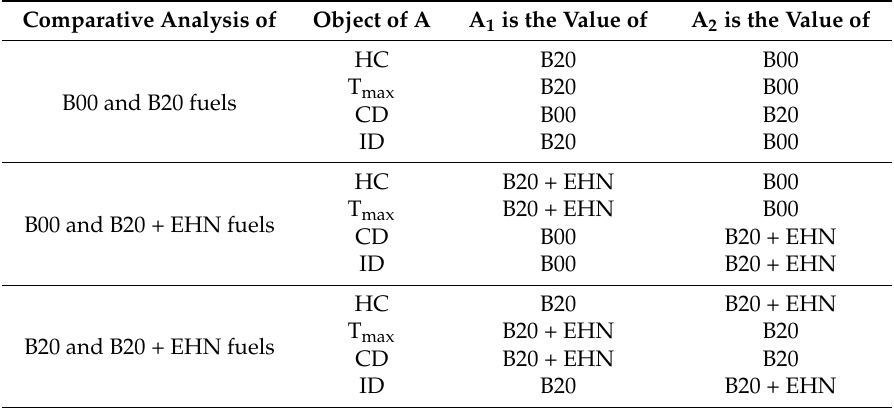
Table 5. Parameters in the definitions of ∆ HC, ∆ T max , ∆ CD, and ∆